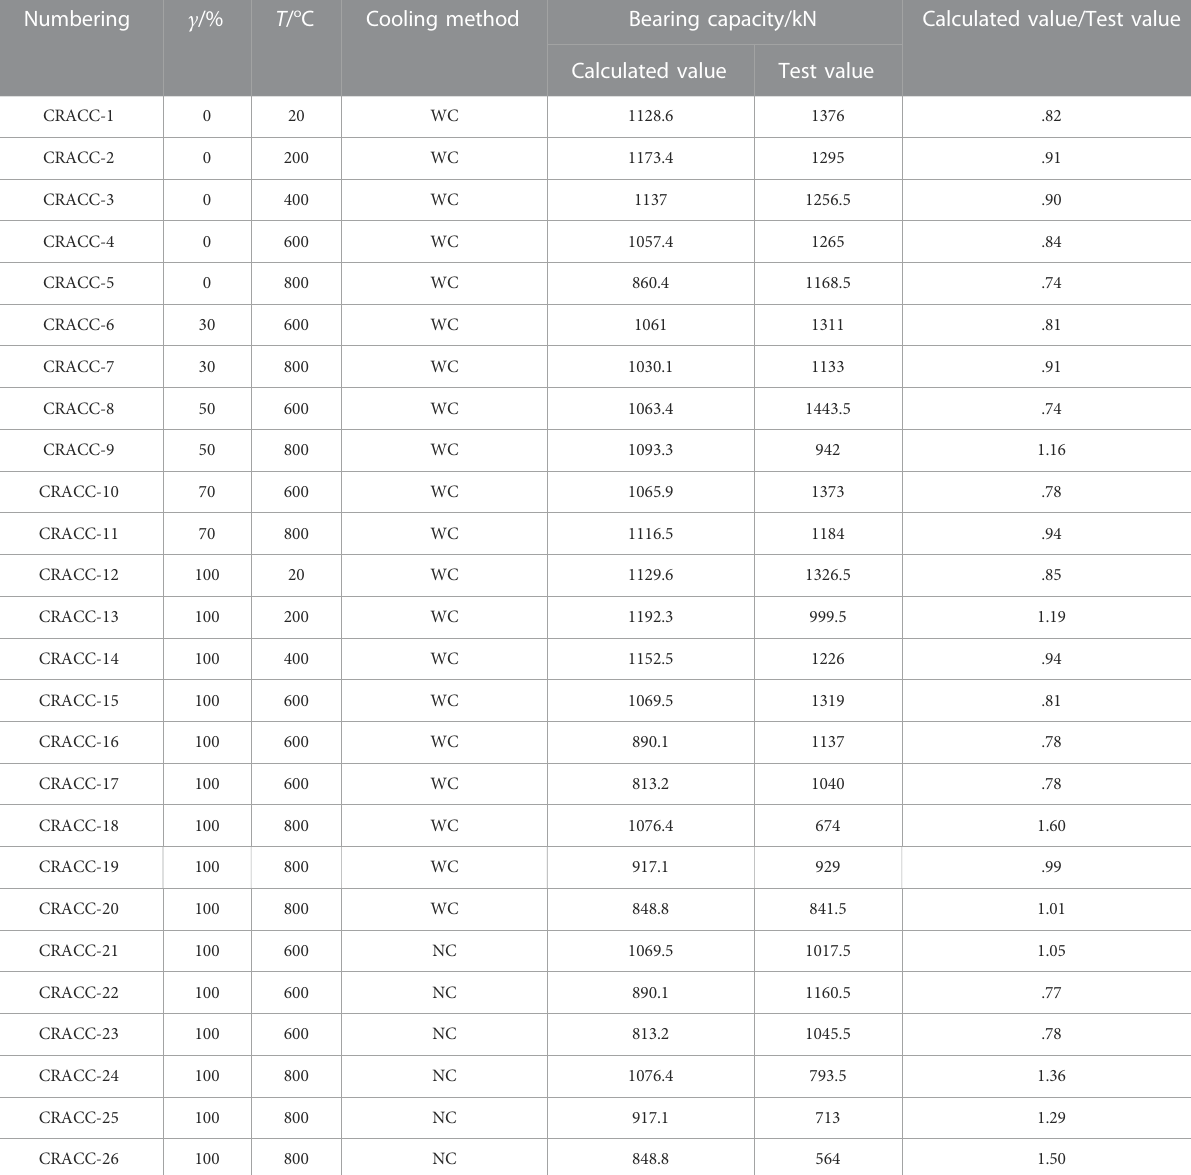
TABLE 5 Comparison between calculated and measured values of bearing capacity of